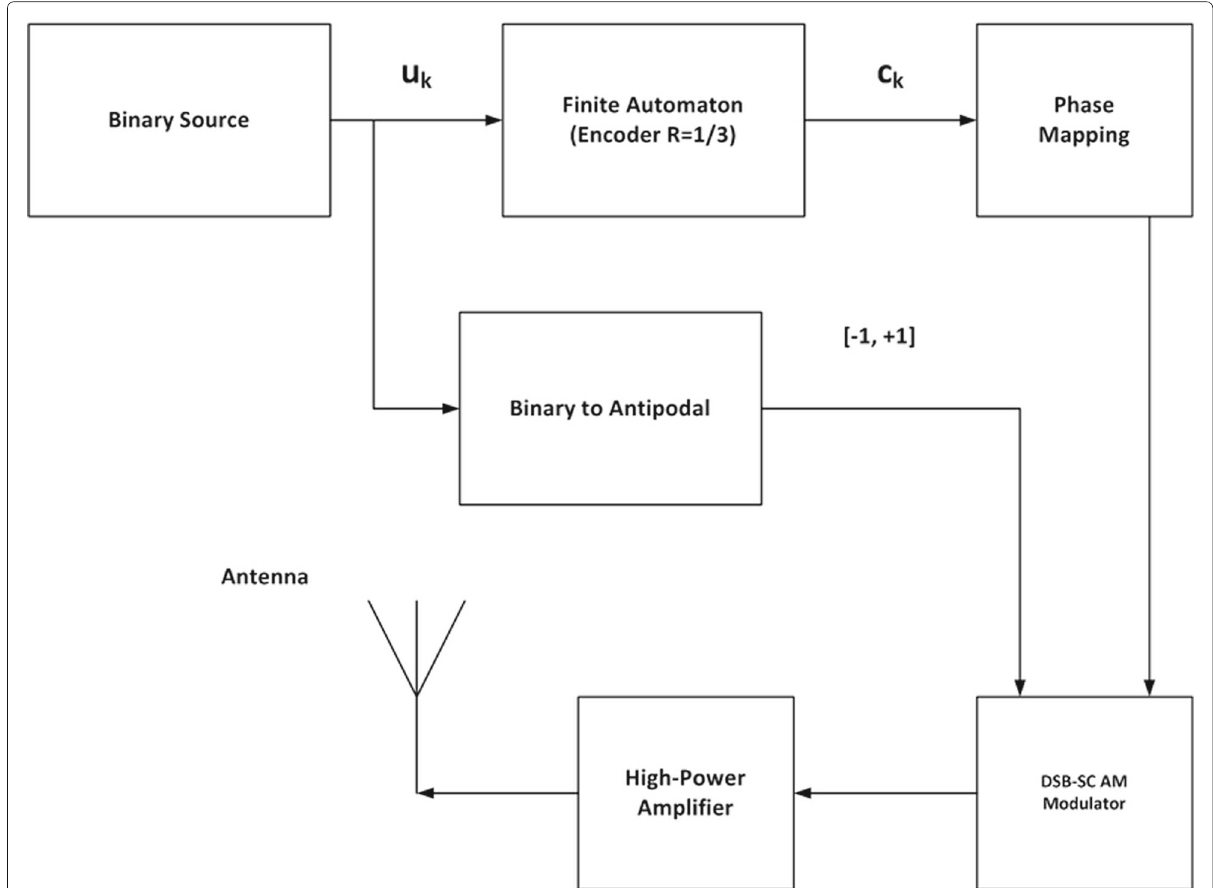
Fig. 1 The DSB-SC AM modulator. The proposed transmitter; it is a DSB-SC AM